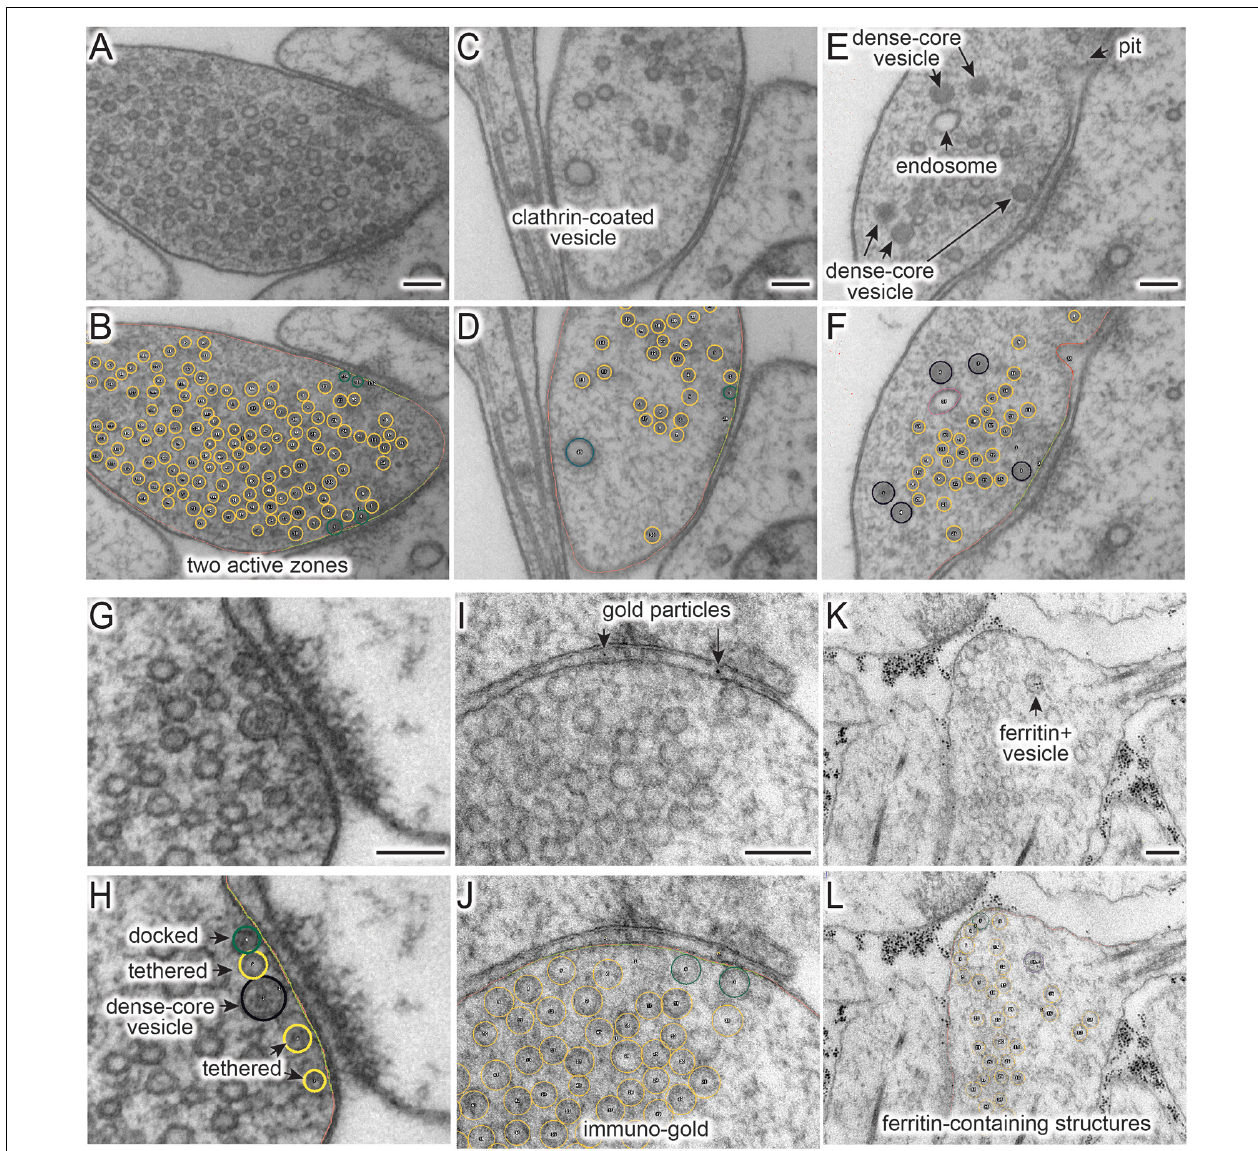
FIGURE 2 | (A–L) Example micrographs (A,C,E,G,I,K) and their annotations (B,D,G,H,J,L) , showing structures that can be traced using the ImageJ/Fiji macros (“synapsEM_analysis_macro.txt”). (A,B) Multiple active zones in a single synaptic profile. (C,D) Clathrin-coated vesicle. (E,F) Dense-core vesicles and endosomes. (G,H) Docked or tethered synaptic vesicles in active zones. (I,J) Gold particles. (K,L) Ferritin-containing vesicles. See Table 2 for the full list of structures and hot keys to enter into the ROI manager. Scale bars = 100